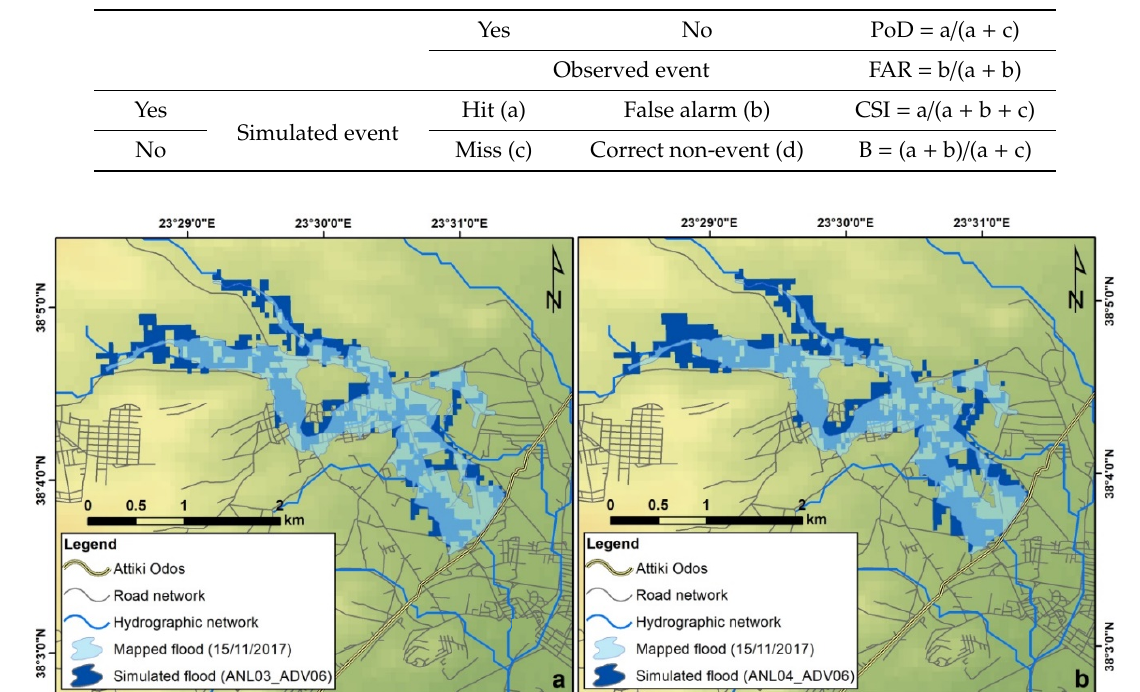
Contingency table for validation and statistical scores definitions, based on the contingency table.